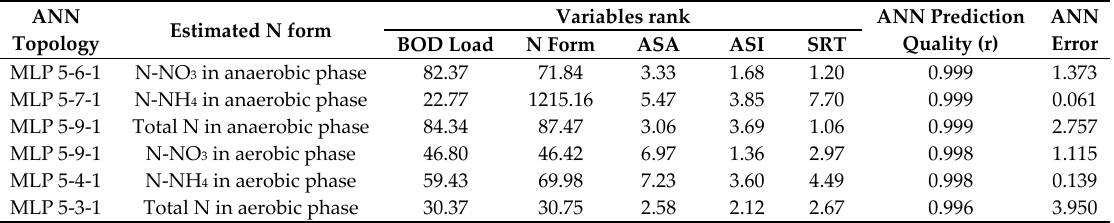
Table 1. Sensitivity analysis and artificial neural networks (ANNs) matching to observed values.